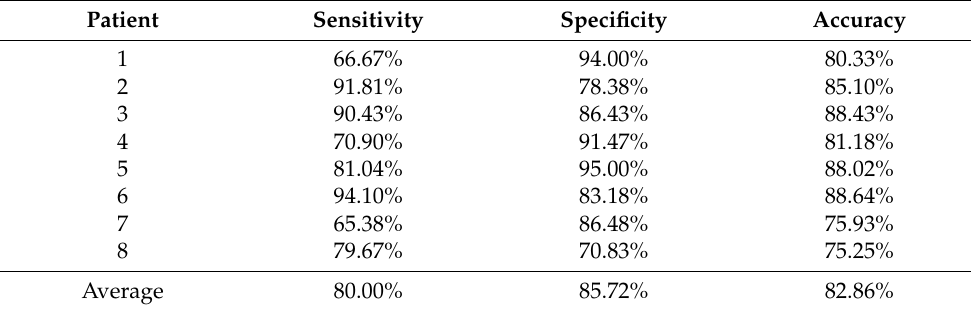
Table 3. The classification results of the ACGRU model for each subject. Patient